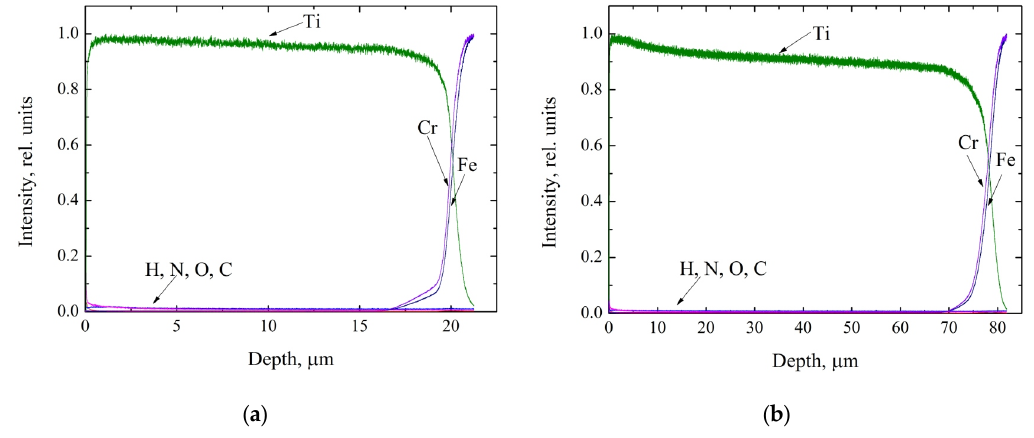
Figure 3. Depth distribution profile of chemical elements for 20 µm ( a ) and 80 µm ( b ) titanium coatings.